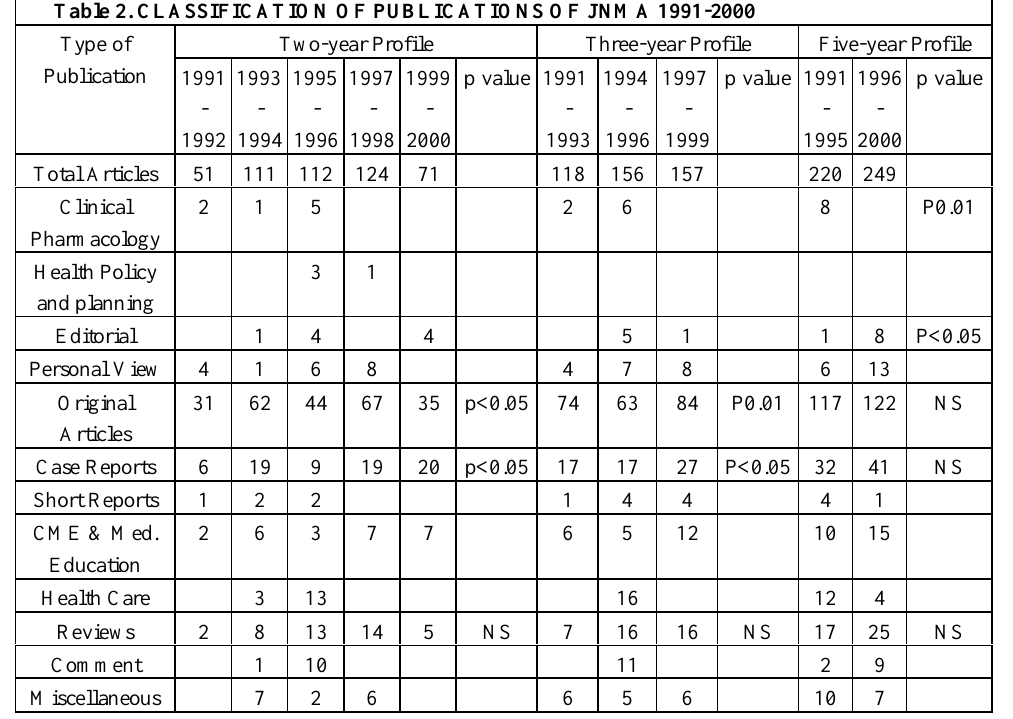
Table 2. CLASSIFICATION OF PUBLICATIONS OF JNMA